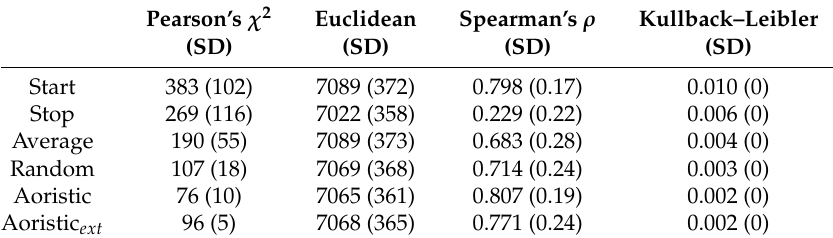
Table 6. Mean and standard deviation for the four evaluation measures and six temporal analysis methods that were evaluated with the weekday data over each of the five years.